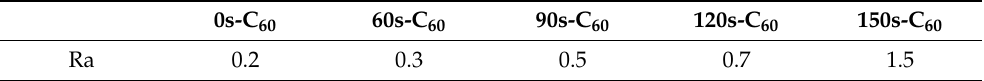
Figure 4. AFM characterization of the thickness of ( a ) 60s-C 60 nanolayer, ( b ) 90s-C 60 nanolayer, ( c ) 120s-C 60 nanolayer, and ( d ) 150s-C 60 nanolayer after partial removal; AFM characterization of surface morphology of ( e ) 60s-C 60 nanolayer, ( f ) 90s-C 60 nanolayer, ( g ) 120s-C 60 nanolayer, and ( h ) 150s-C 60 nanolayer. Table 2. Average surface roughness of C 60 with different thermal evaporation times.